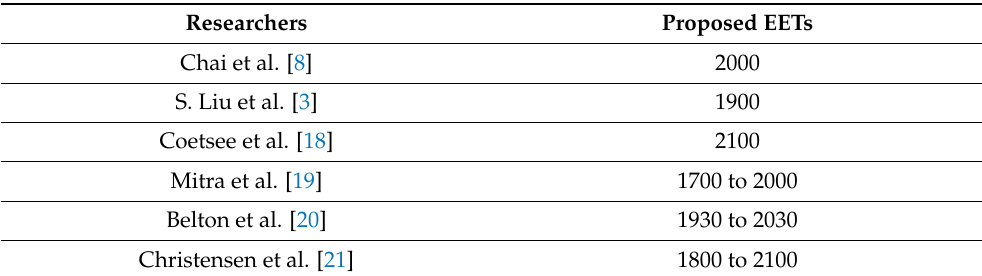
Table 1. EET values concluded by different investigators ( ◦